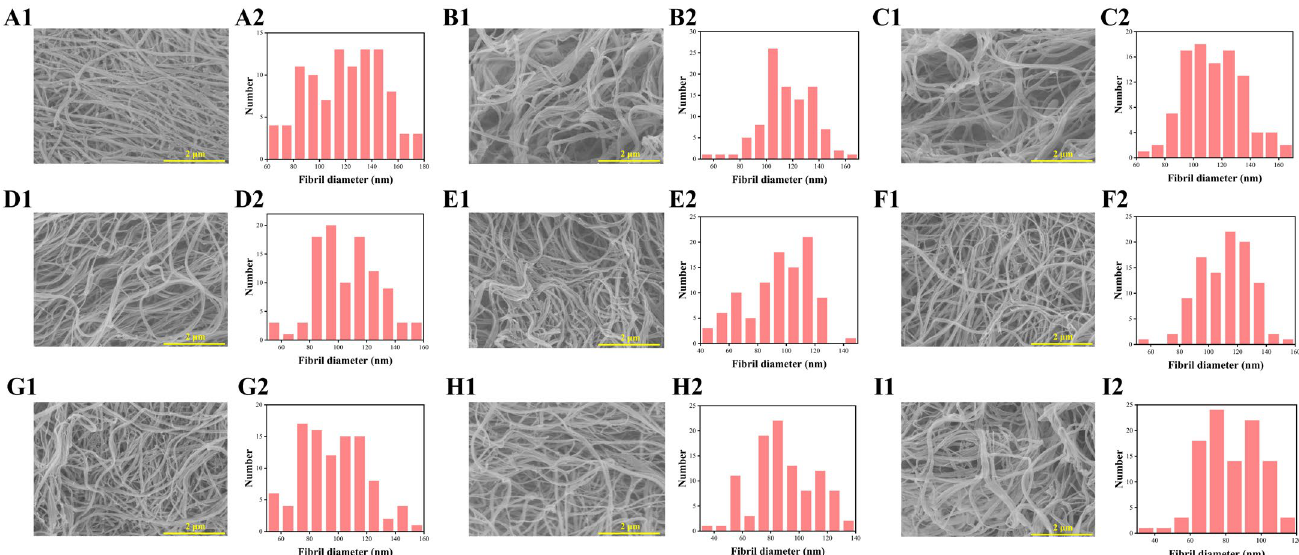
Figure 3. SEM images of collagen fibrils of C0W0m ( A1 ), C50W10m ( B1 ), C100W10m ( C1 ),